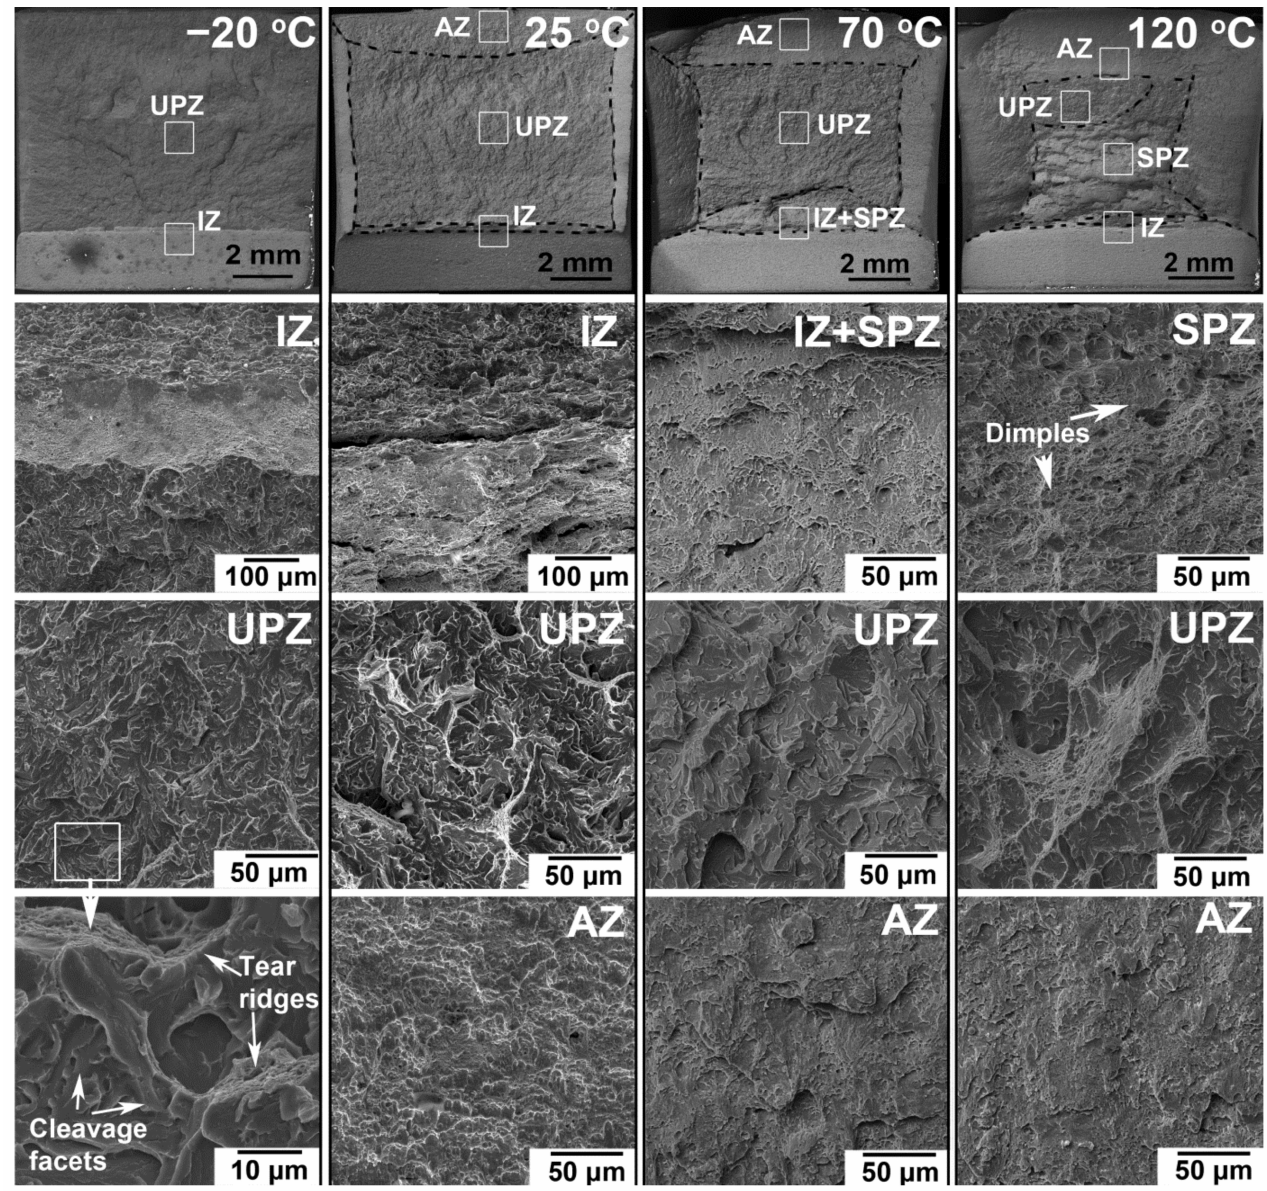
Figure 12. Fractography of the 12% Cr steel samples subjected to the TMP and the following impact tests at − 20 ◦ C, 25 ◦ C, 70 ◦ C, and 120 ◦